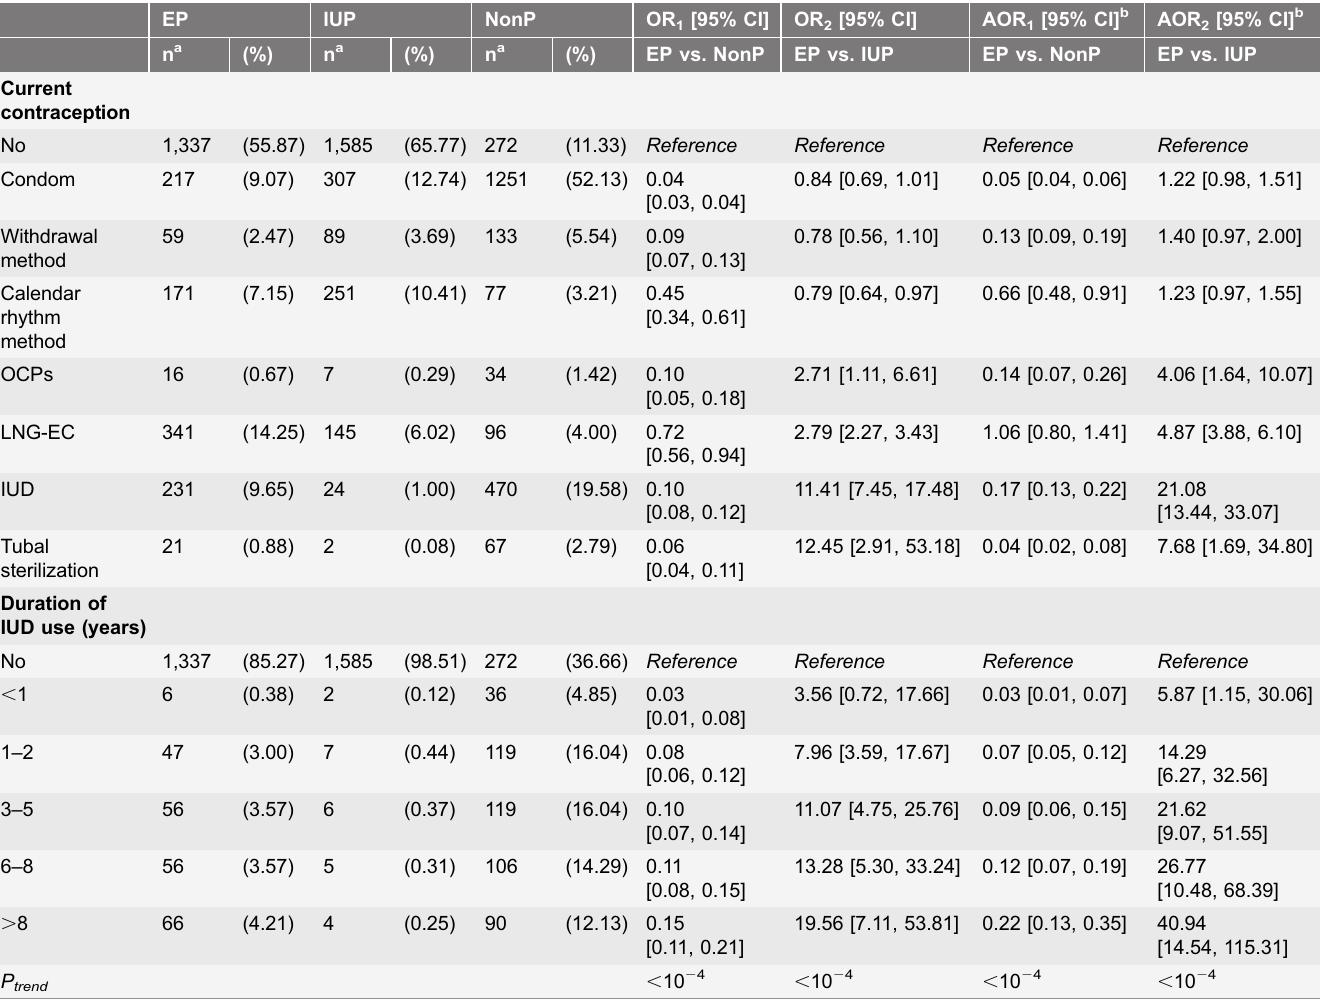
Table 4. The association between EP risk and contraceptive method used in the current